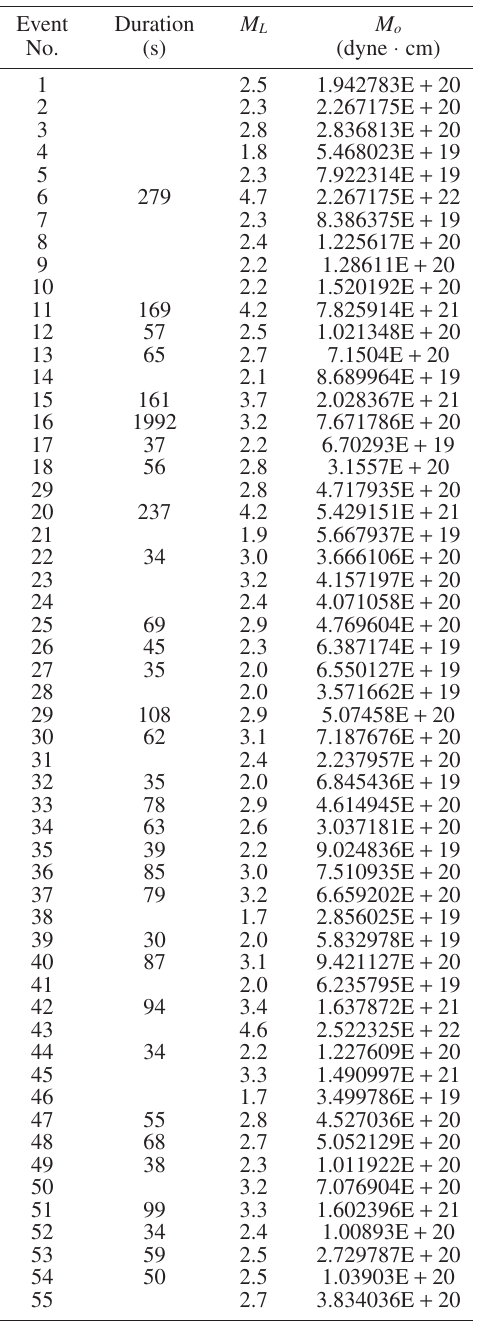
Table II. Seismic moment of the events under